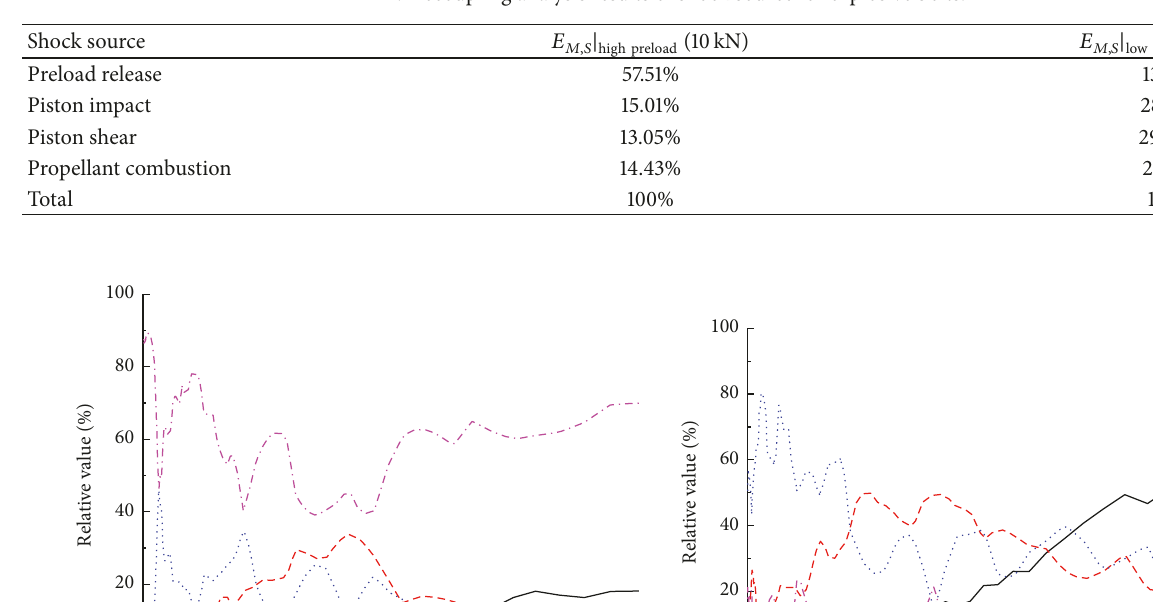
Table 2: Decoupling analysis results of shock source for explosive bolts.